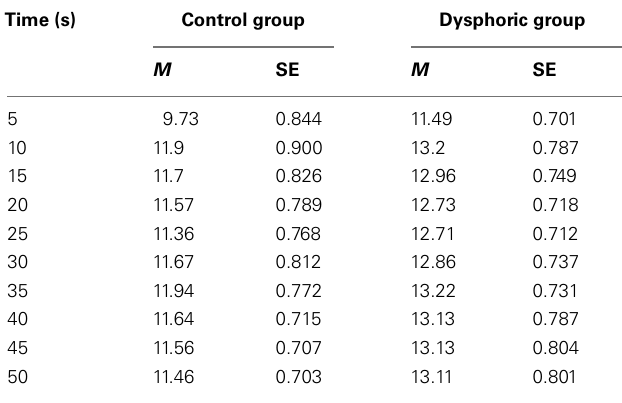
Table 1 | Mean probability of responding on the late button [ p (late)] for the control and dysphoric groups during each 5s time segment averaged over 14 reinforced trials.